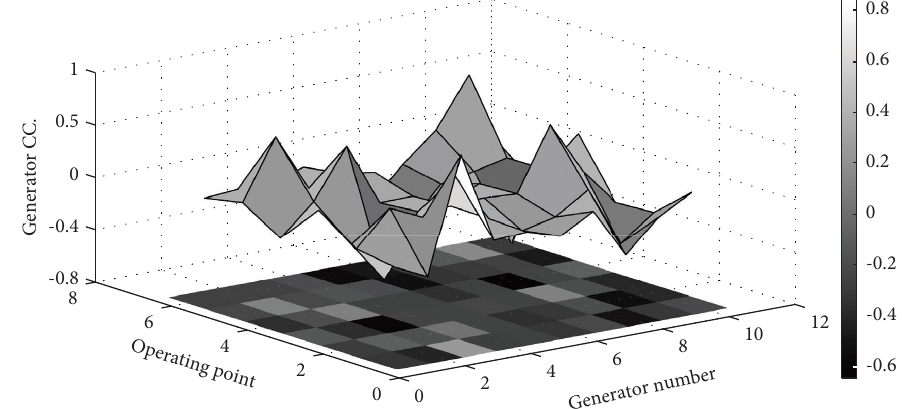
Figure 4: Generator contribution coefcient at diferent operating points for IEEE 39-bus system.